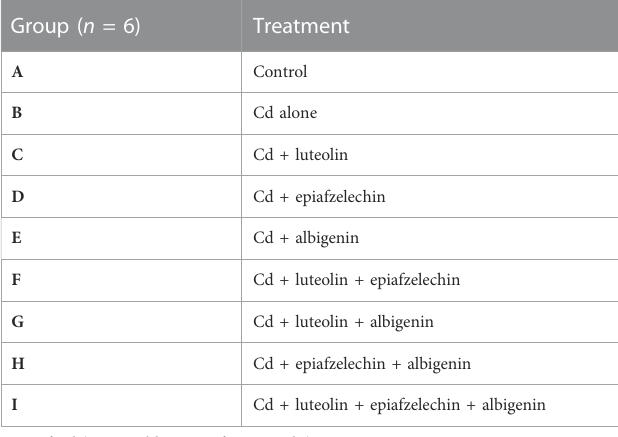
TABLE 1 Experimental